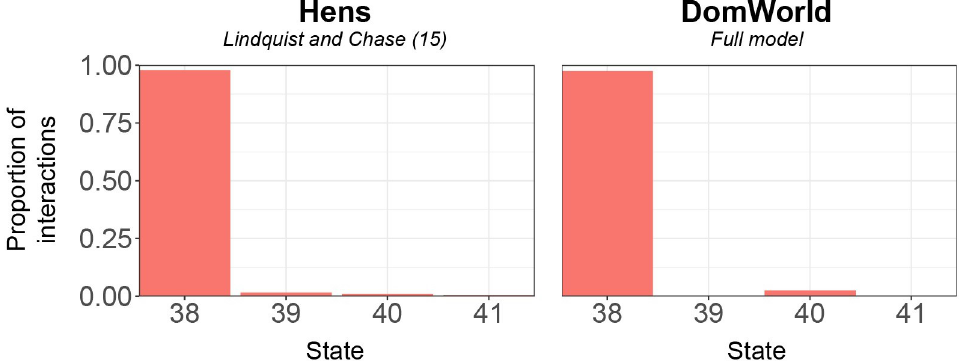
Fig 8. Comparison of the frequency of complete states (six links) in the dominance network between the model DomWorld and hens as reported by Lindquist and Chase [21].